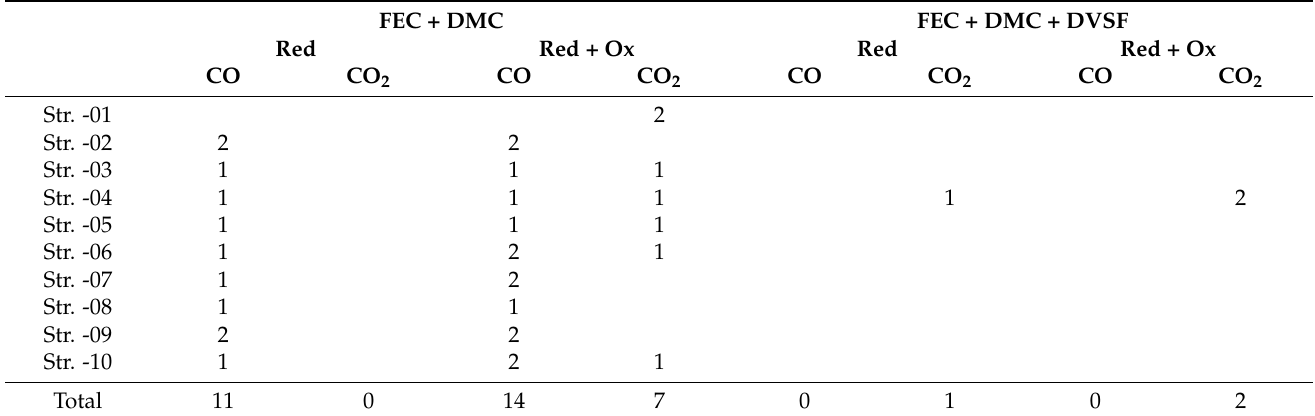
Table 1. Newly generated gas molecules through reductive reactions and following oxidation reactions of mixture electrolyte with and without the divinyl sulfone (DVSF)